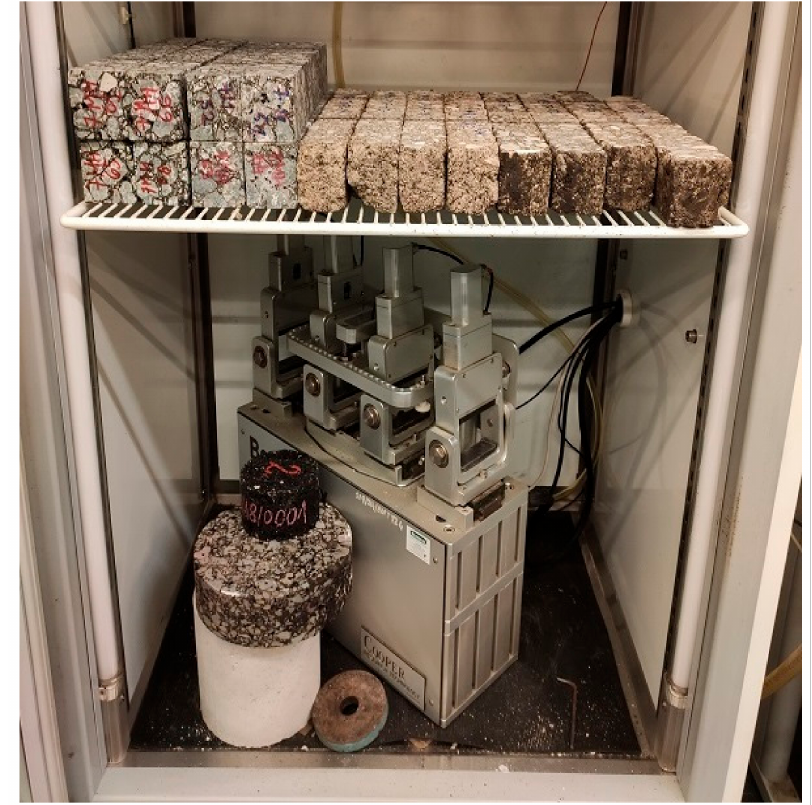
Figure 3. Testing machine and first sample